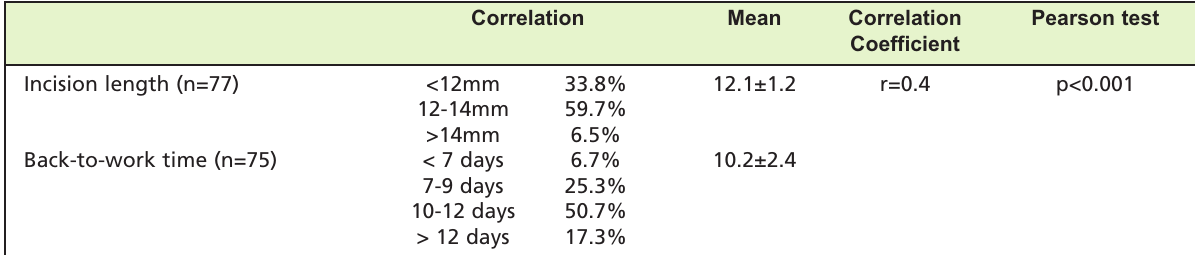
Incision length, back-to-work time, and their correlation Table VI: Correlation Mean